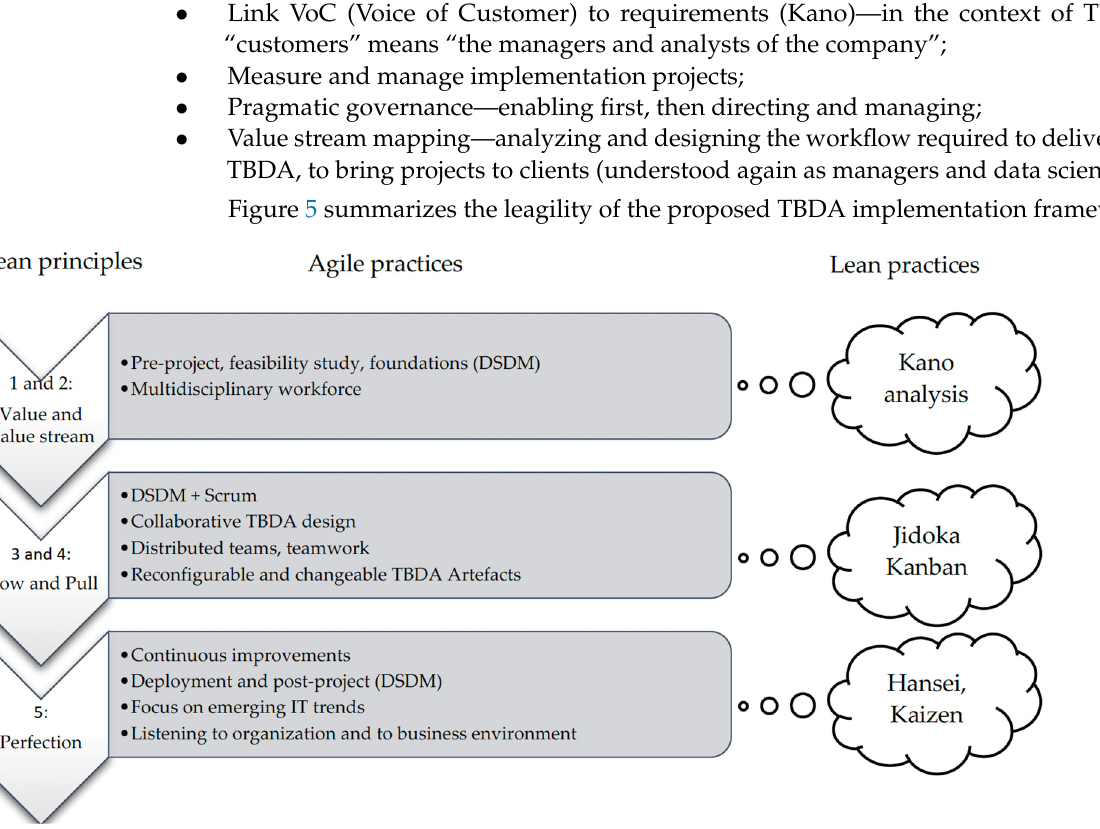
Figure 5. The leagility of the TBDA implementation framework.